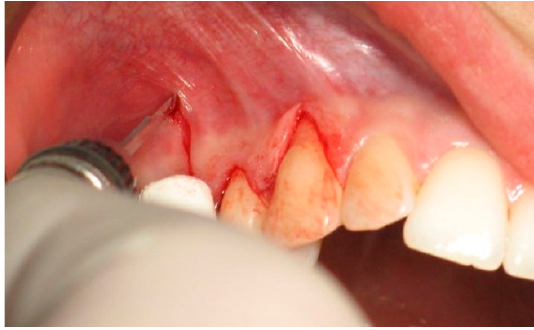
Figure 4. Surgical incisions for flap preparation.